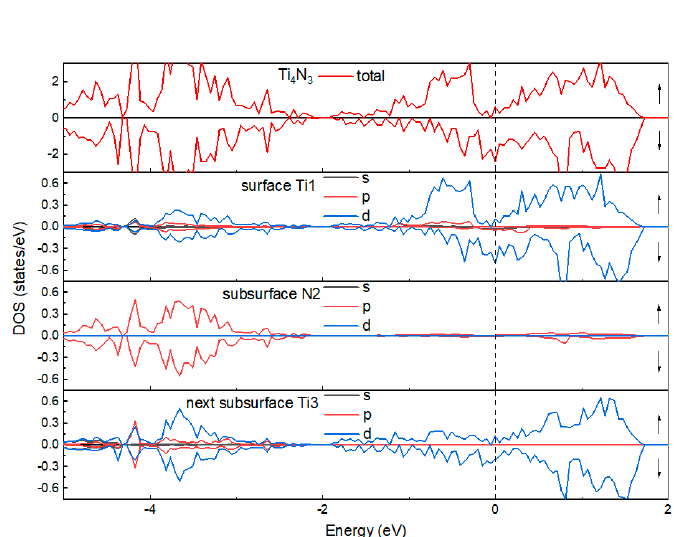
Figure 2. Total density of states (TDOS) and partial density of states (PDOS) Ti 4 N 3 nanosheet. ↑ and ↓ indicate the spin-up and spin-down orbitals, respectively. The Fermi level (dashed vertical line) is set to zero. The TDOS is transited to a primitive cell.